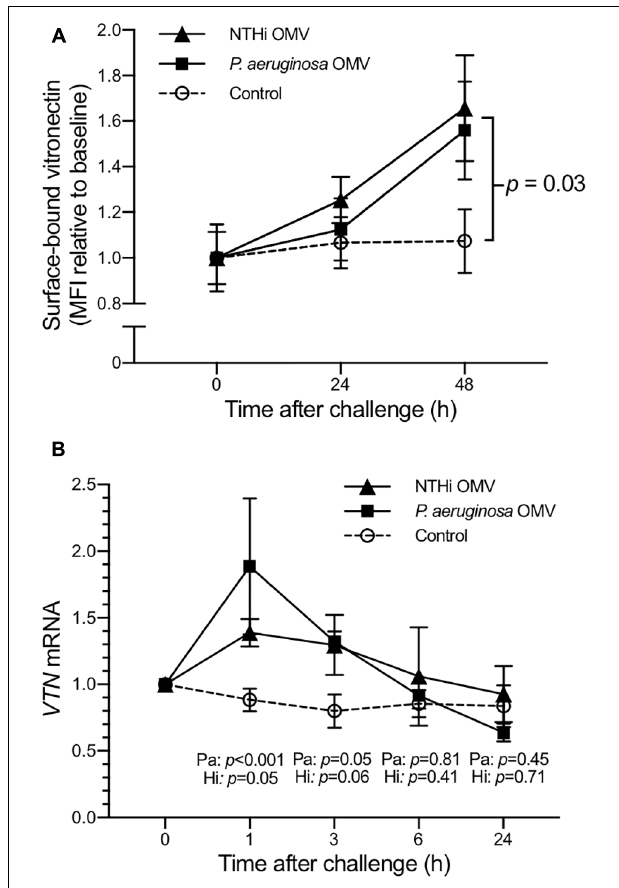
FIGURE 6 | Human type II alveolar cells (A549) produce vitronectin after stimulation with bacterial OMV. Surface-bound vitronectin was detected on A549 epithelial cells by flow cytometry (A) . Cells were starved for 18 h prior to the experiment. Following the addition of OMV (5 µ g) from P. aeruginosa (solid squares) or nontypeable H. influenzae (solid triangles), the cells were harvested at indicated time points. Untreated cells were used as controls (open circles). Mean values of two biological replicates are shown, each comprising three technical repetitions. ANOVA was used to calculate the p -values. A corresponding increase in vitronectin ( VTN ) mRNA levels was seen 1–3 h after challenge with 1 µ g OMV from either bacterial species (B) . Symbols represent mean values and error bars represent standard error of the mean of three biological replicates. The difference in mean values between respective bacterial species and controls were assessed using a t